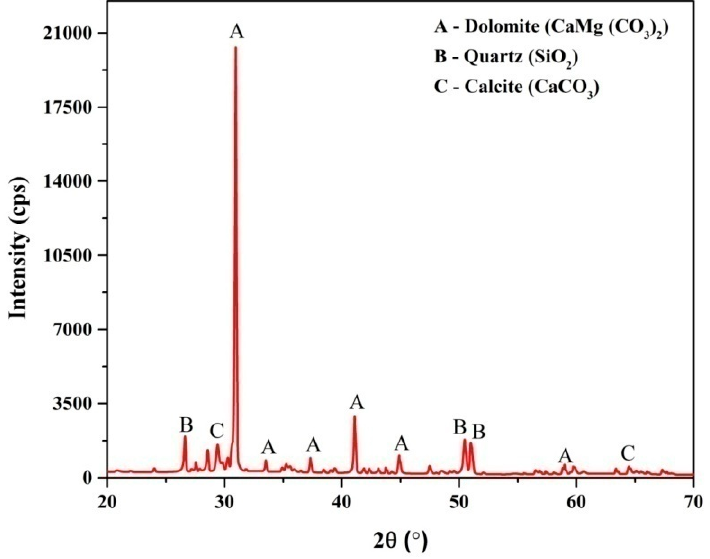
Figure 3. XRD pattern of marble waste particulates.